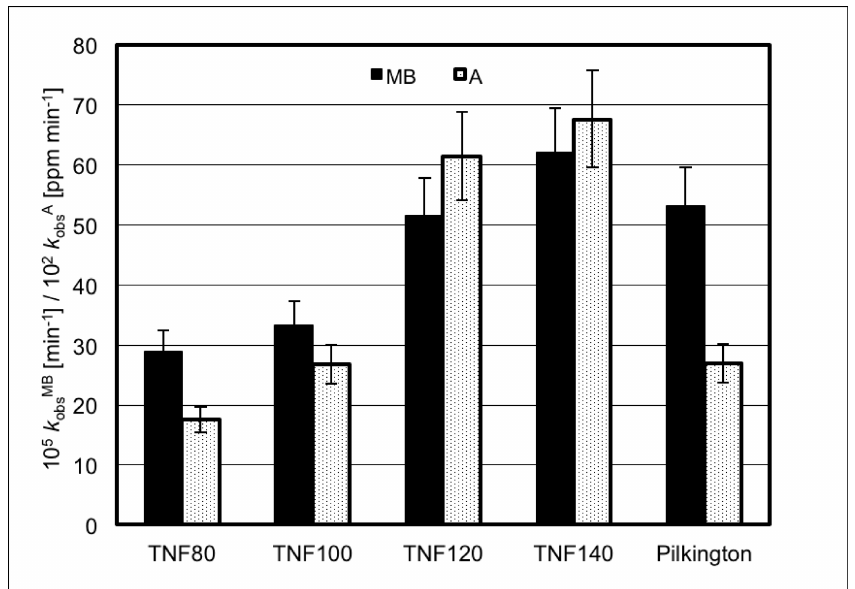
Figure 11. The observable rate constants for methylene blue and acetone degradation under UV light irradiation in the presence of titania nanofibers.